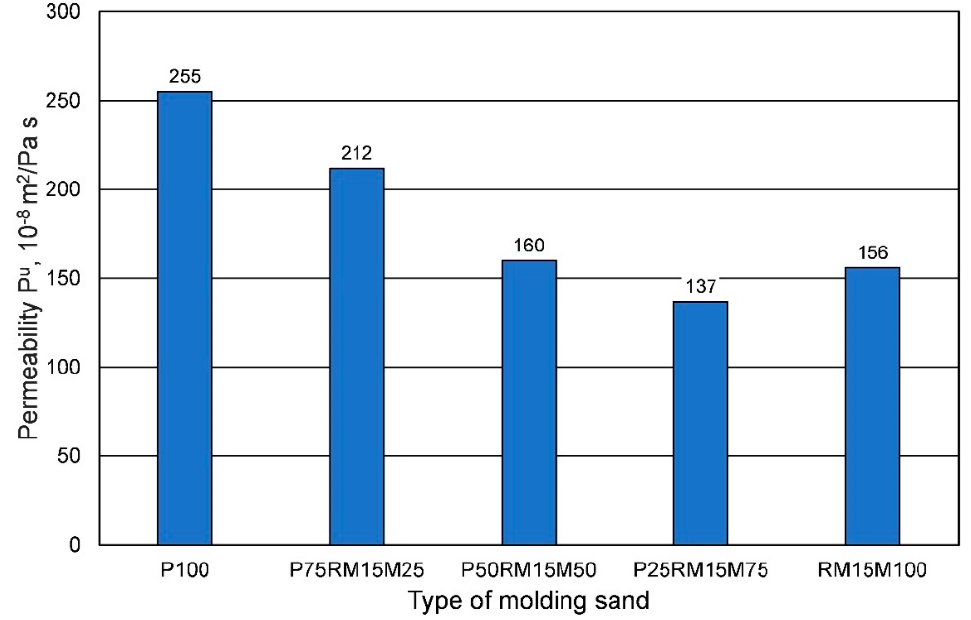
Figure 22. Permeability P u of the molding sand, depending on the grain matrix used. However, the abrasion resistance of the tested molding sands made on the basis of various compositions of grain matrices does not show a clear tendency, although the addition of reclaimed material slightly increases the tested parameter (Figure